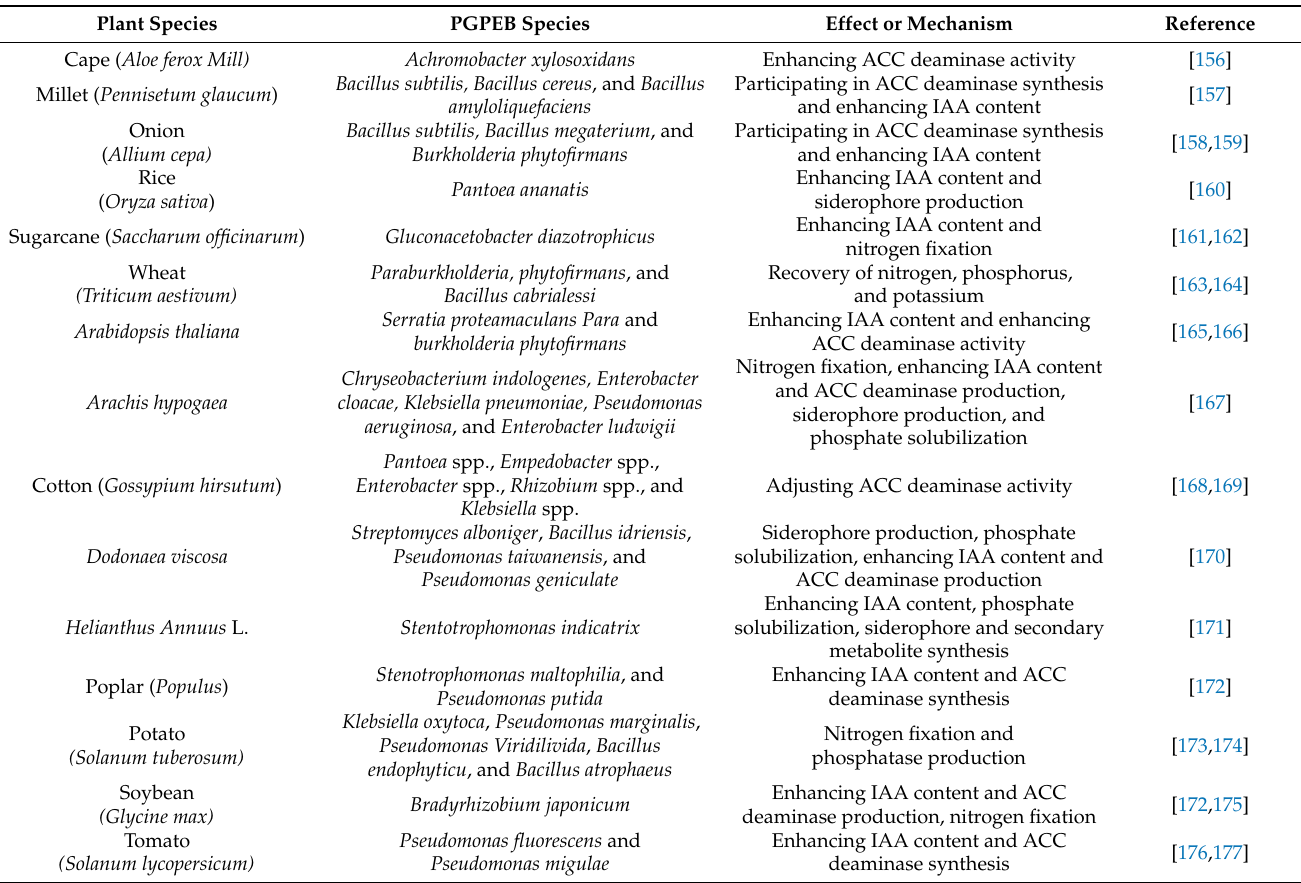
Table 2. Interaction of plant growth-promoting rhizobacteria (PGPEB) under stress and their benefi- cial